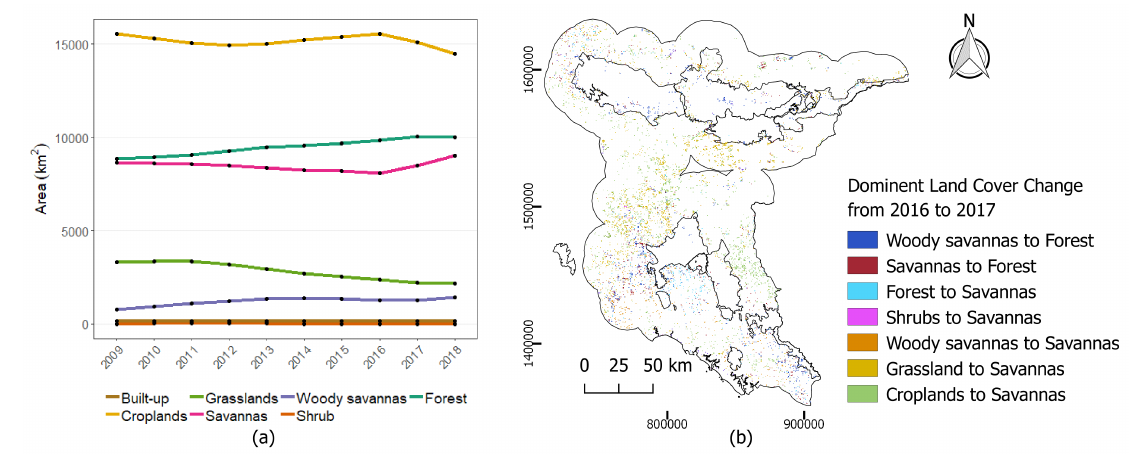
Figure 9. ( a ) Areas of different land cover types from 2009 to 2018 based on the reclassified MODIS land cover classes ( b ) Dominant land cover changes detected from 2016 to